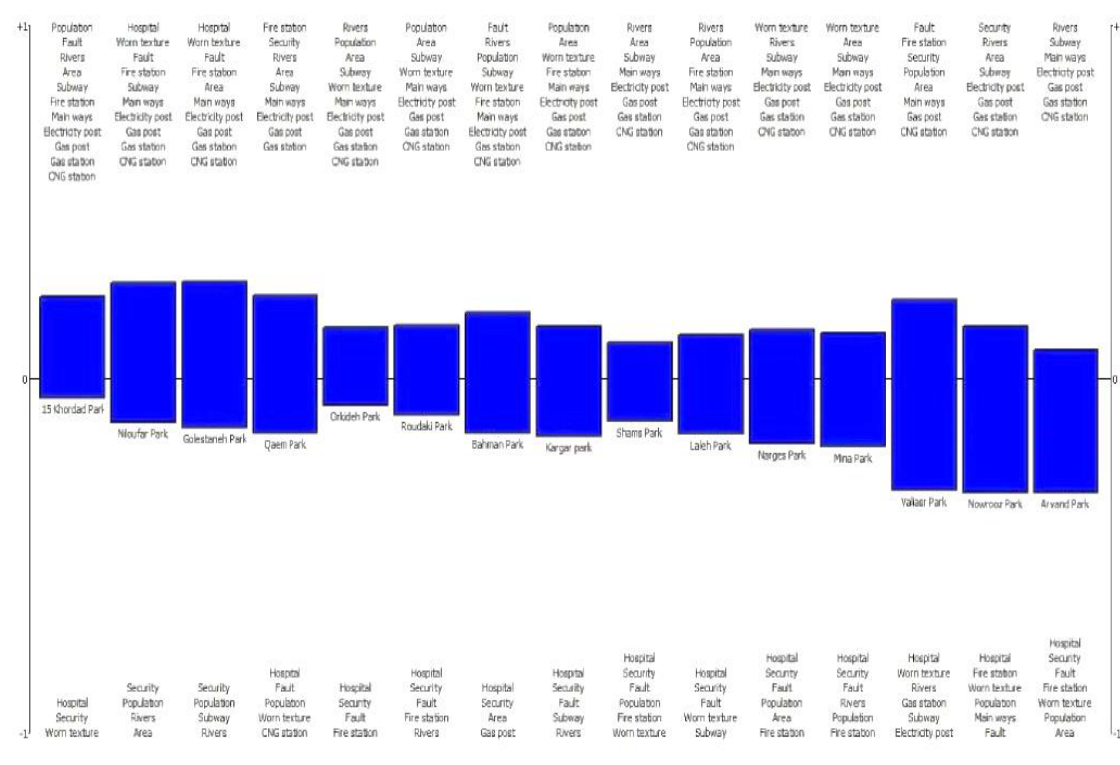
Fig. 4. PROMETHEE